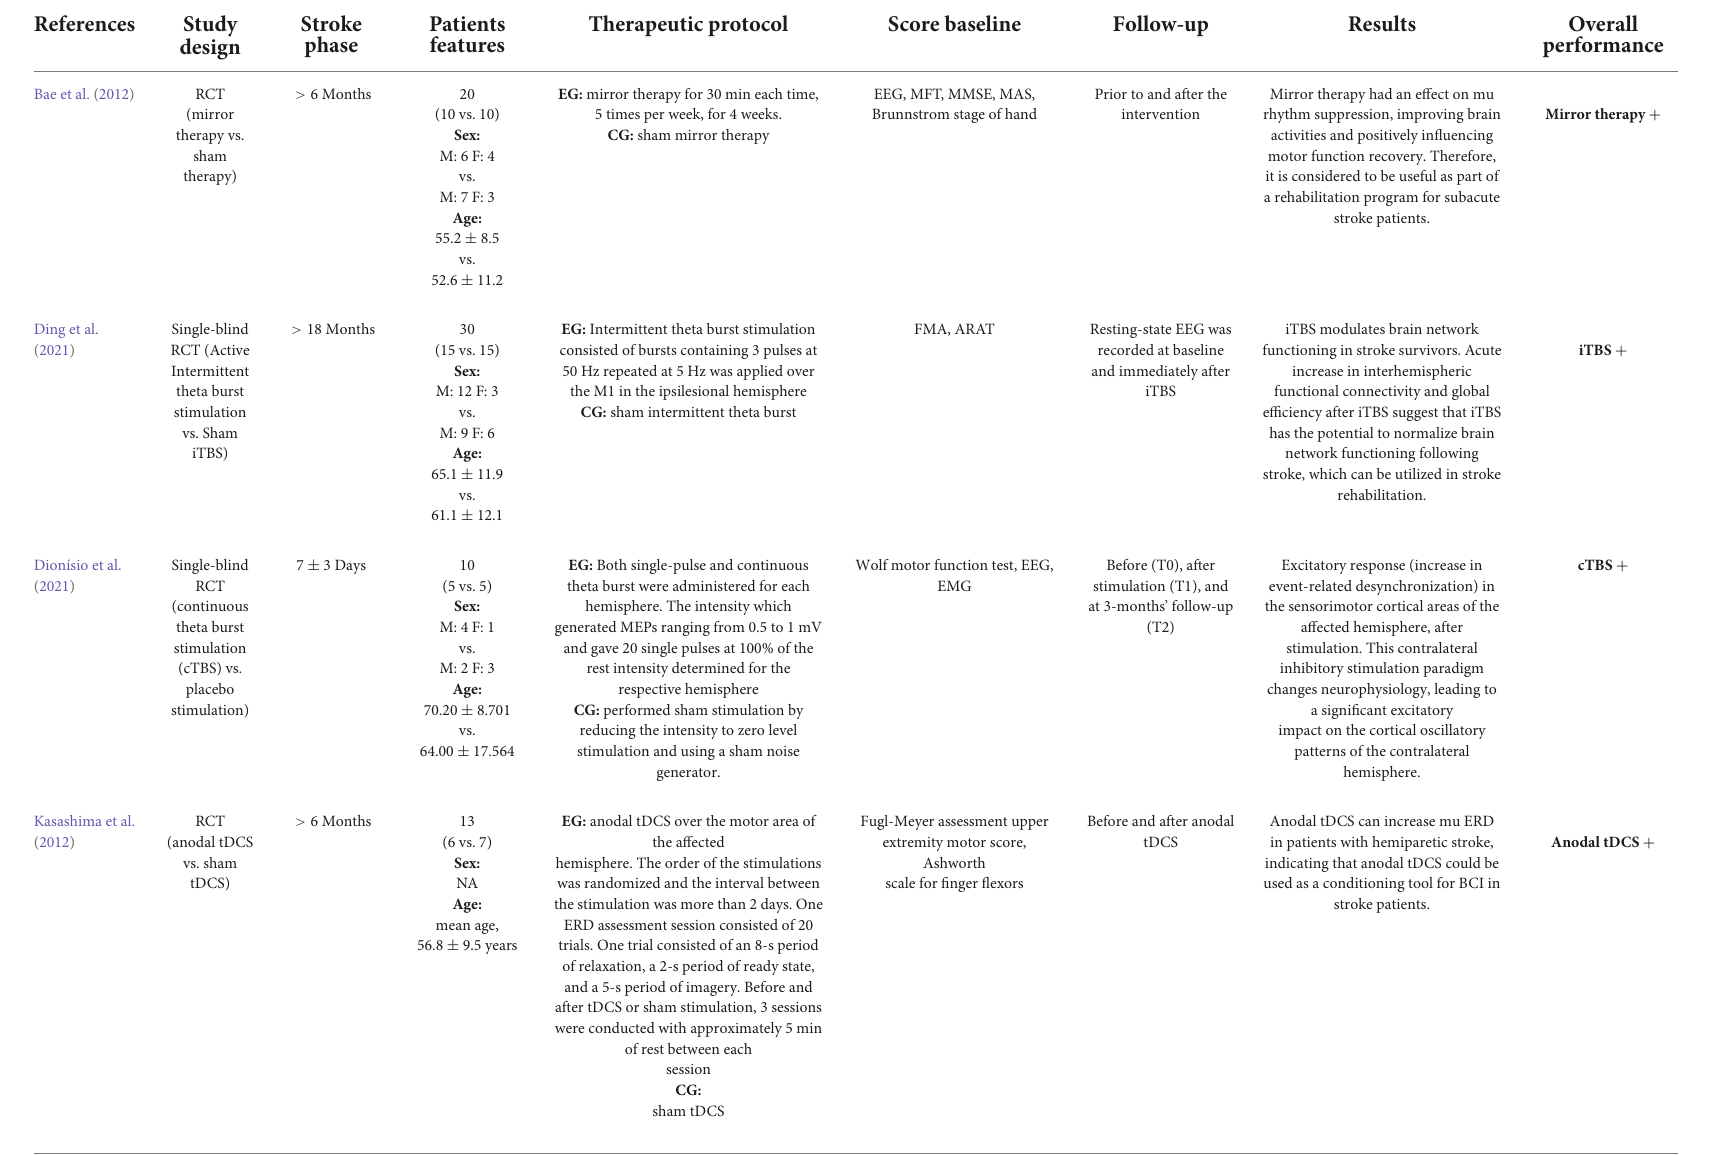
TABLE 1 Synopsis of all the RCTs included in the